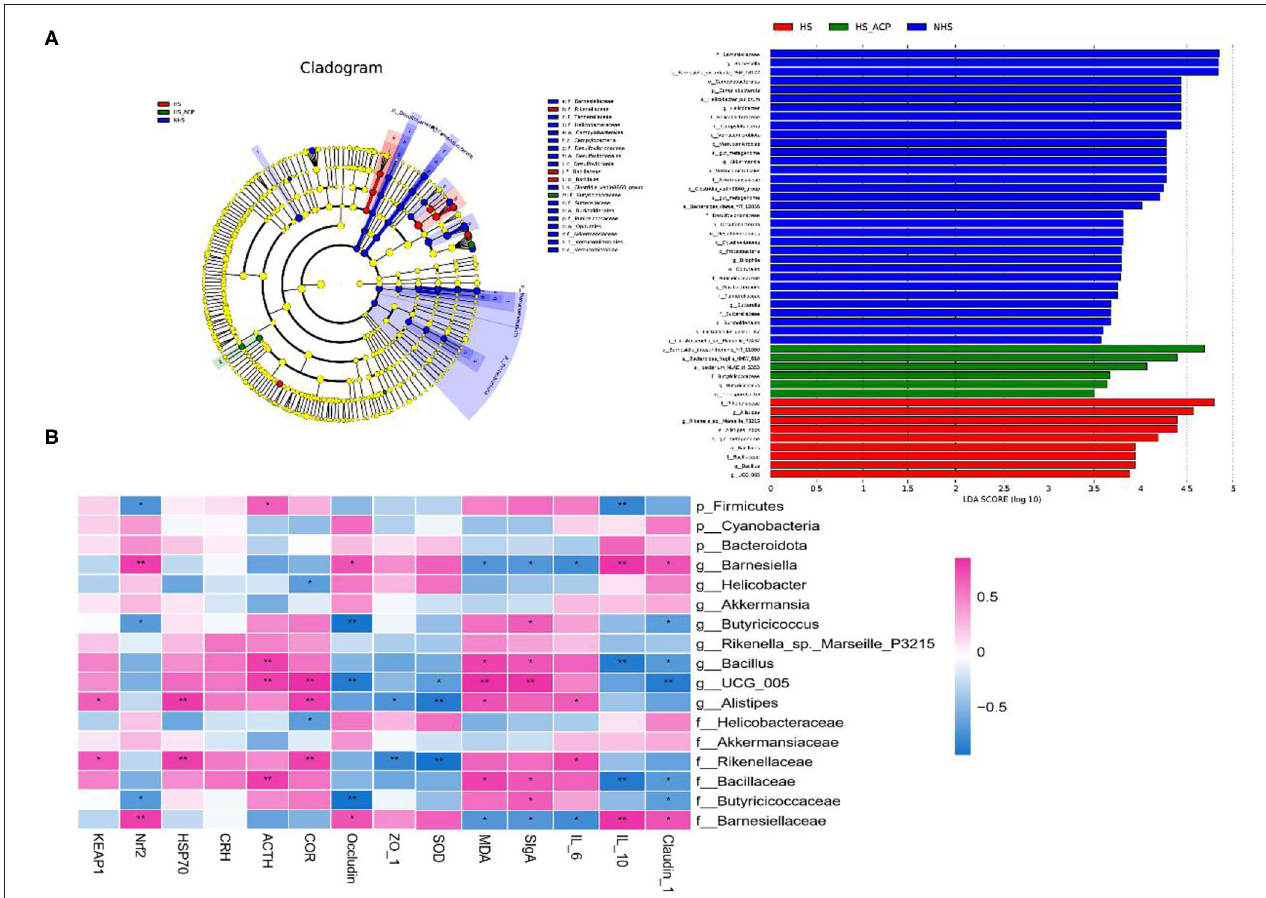
FIGURE 8 | (A) Difference in dominant microorganisms among each group via cladogram and distribution histogram based on linear discriminant analysis (LDA). Only the results meeting an LDA significant threshold of > 3.5 were shown. The greater the LDA score, the more significant the phylotype microbiota was in the comparison, (B) A heatmap showing the Spearman correlation coefficient between several significant enriched intestinal bacteria and measurement parameters. Red cells represent positive correlation and blue cells represent negative correlation. * p < 0.05, ** p <